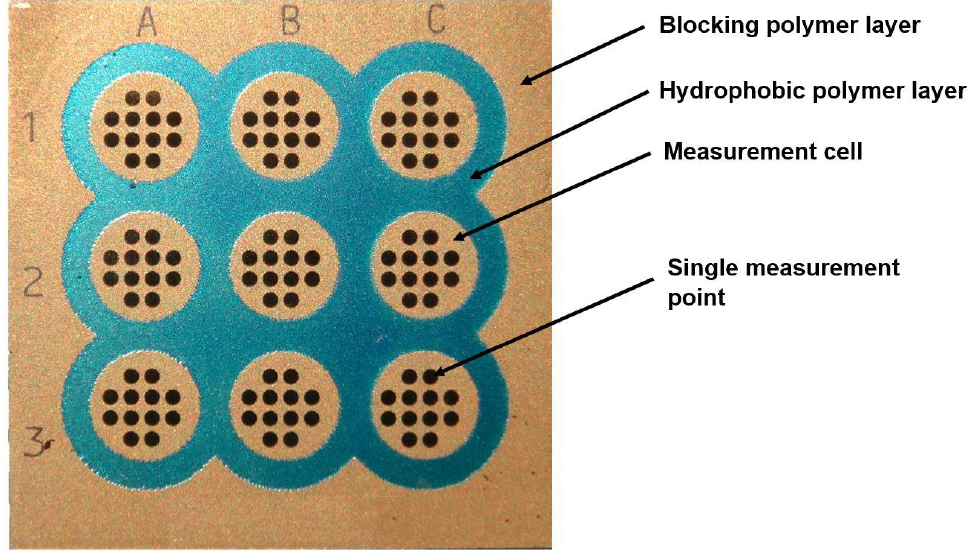
Figure 1. Architecture of chip in the array SPRi